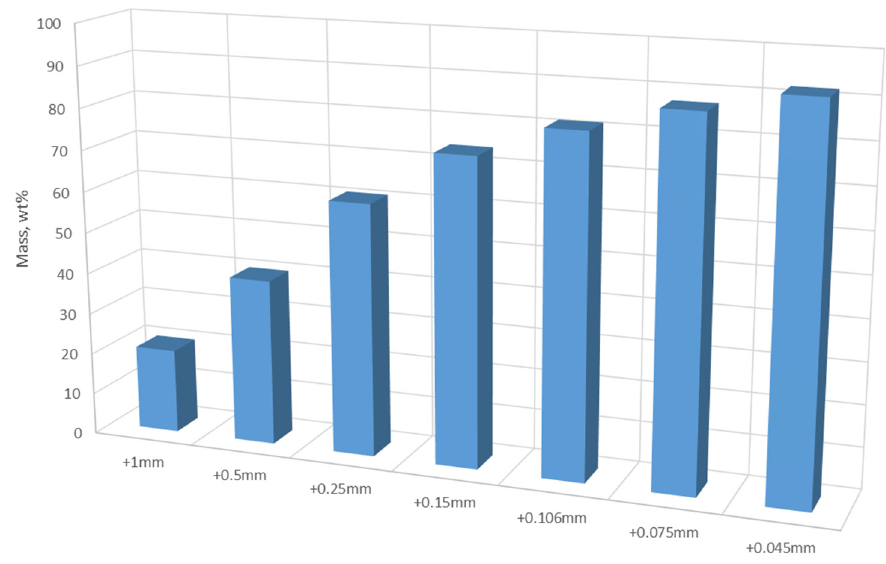
Figure 1. Particle size distribution.